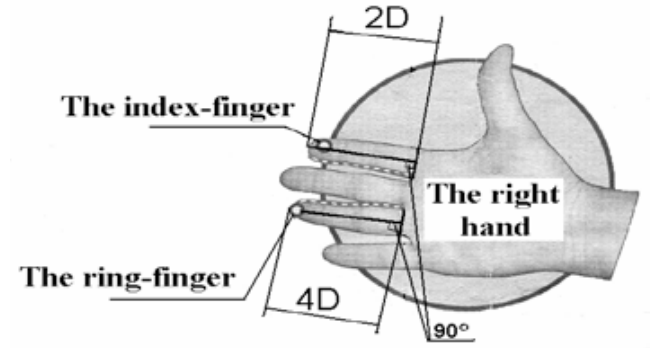
Figure 1 . Methodology of measuring finger proportions